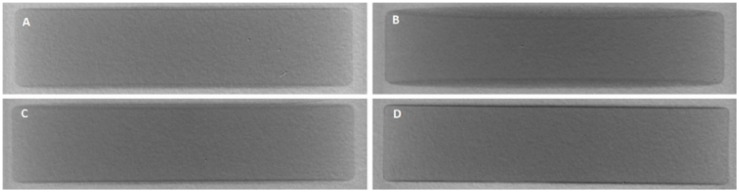
Transverse view of XμCT reconstruction of placebo tablets (13mm) containing contrast material in the coat.Contrast material Bi2O3 is included at 1% w/w and 2.5% w/w, A and B respectively. BaSO4 is included at 2% w/w and 5% w/w, C and D respectively.